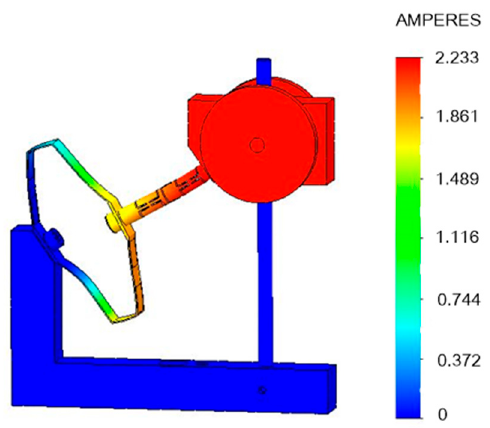
Figure 3. Simulation result of the first mode frequency.